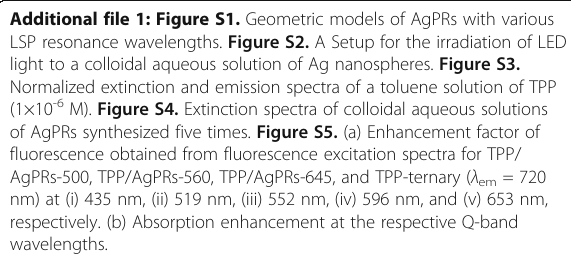
Additional file 1: Figure S1. Geometric models of AgPRs with various LSP resonance wavelengths. Figure S2. A Setup for the irradiation of LED light to a colloidal aqueous solution of Ag nanospheres. Figure S3. Normalized extinction and emission spectra of a toluene solution of TPP (1×10 -6 M). Figure S4. Extinction spectra of colloidal aqueous solutions of AgPRs synthesized five times. Figure S5. (a) Enhancement factor of fluorescence obtained from fluorescence excitation spectra for TPP/ AgPRs-500, TPP/AgPRs-560, TPP/AgPRs-645, and TPP-ternary ( λ em = 720 nm) at (i) 435 nm, (ii) 519 nm, (iii) 552 nm, (iv) 596 nm, and (v) 653 nm, respectively. (b) Absorption enhancement at the respective Q-band